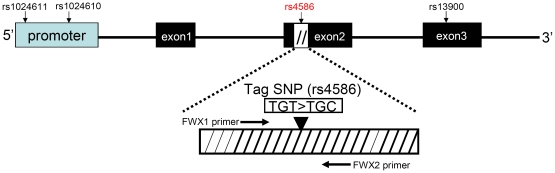

CCL2 gene structure and location of tag SNP rs4586 (T/C), a synonymous mutation at codon 35-Cys in exon 2 of CCL2.